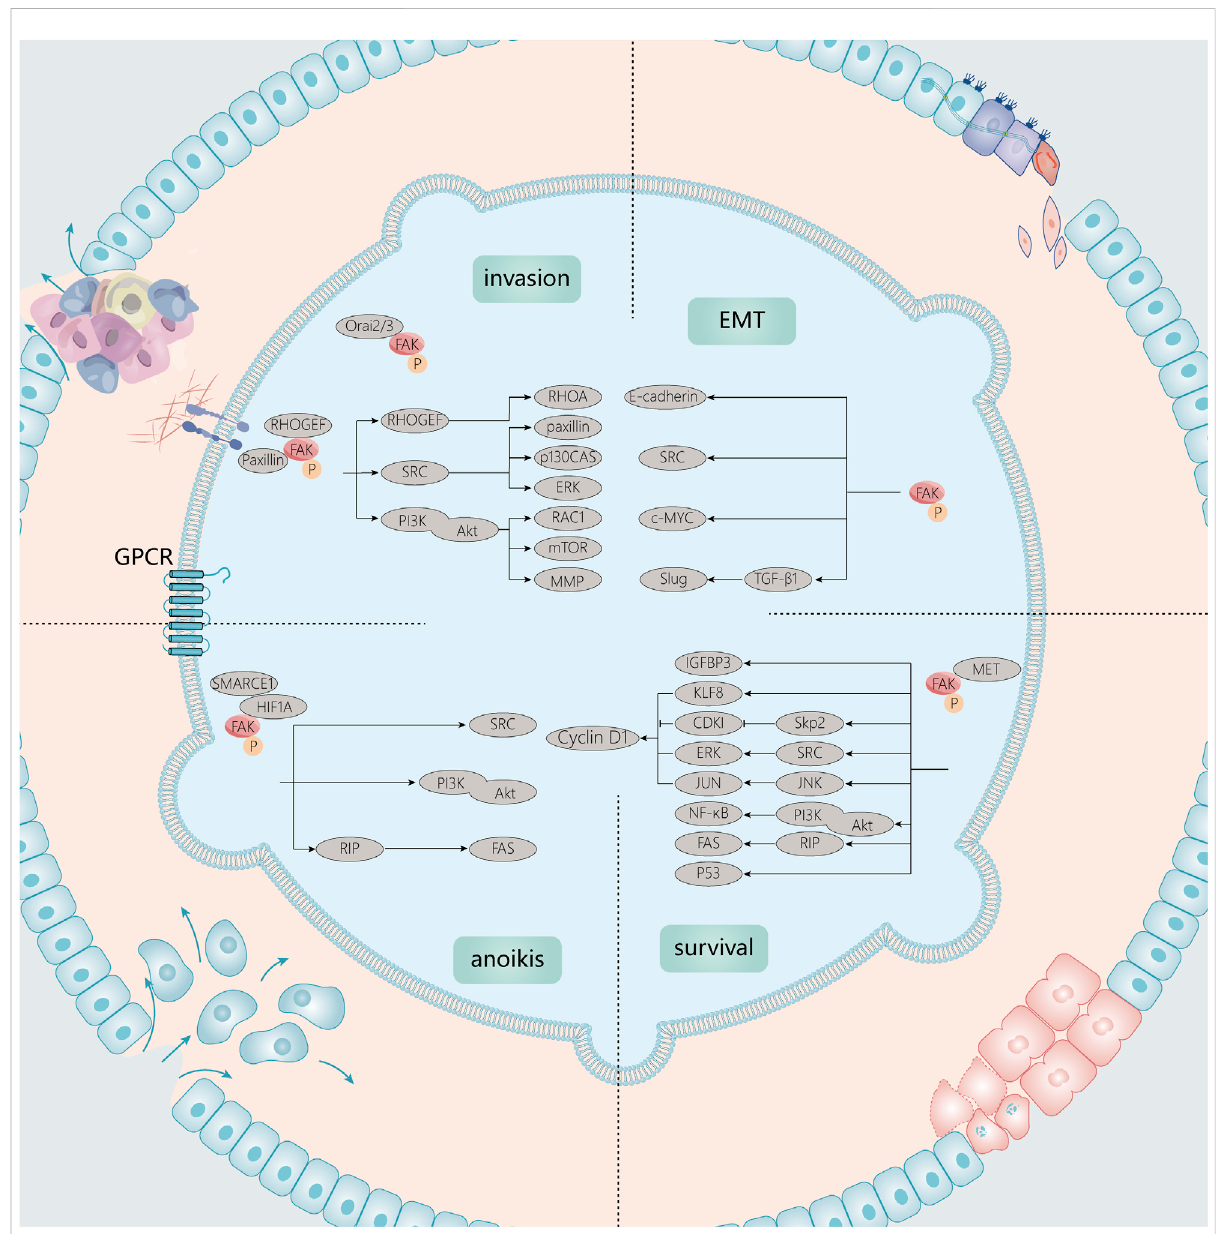
FIGURE 3 Signaling molecules associated with FAK in tumor growth and invasion. Tumor development and metastasis are complex processes. In growth signaling, FAK is closely linked to anoikis, cell cycle, and apoptotic processes. In EMT and invasion, FAK can also function through associated Src, PI3K/Akt, and other signaling